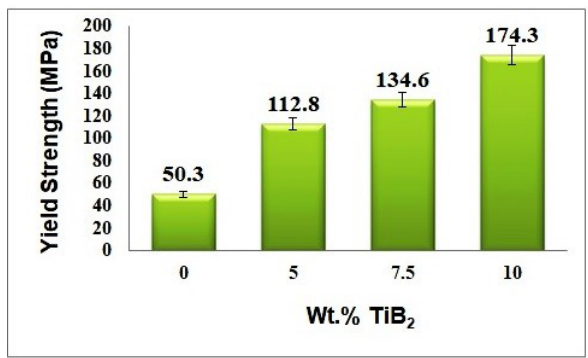
Figure 6: Effect of Yield Strength for various wt% of TiB 2